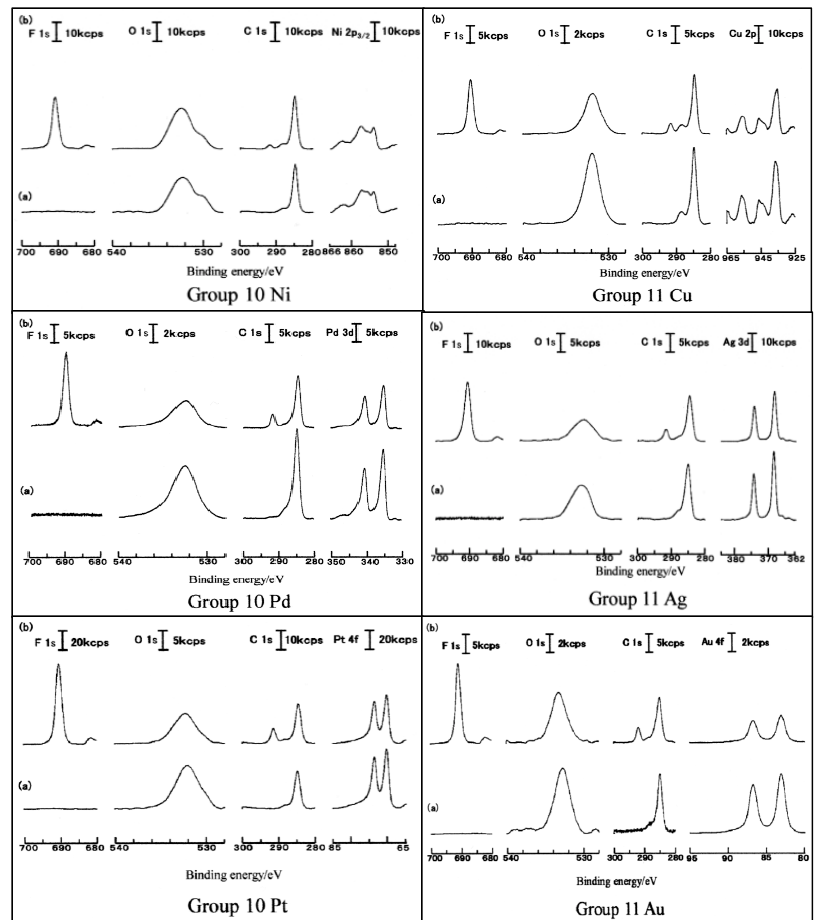
Figure 7. XPS spectra for groups 10 (Ni, Pd, and Pt) and 11 (Cu, Ag, and Au) ( a ) before and ( b ) after the TriboEE measure- ment.